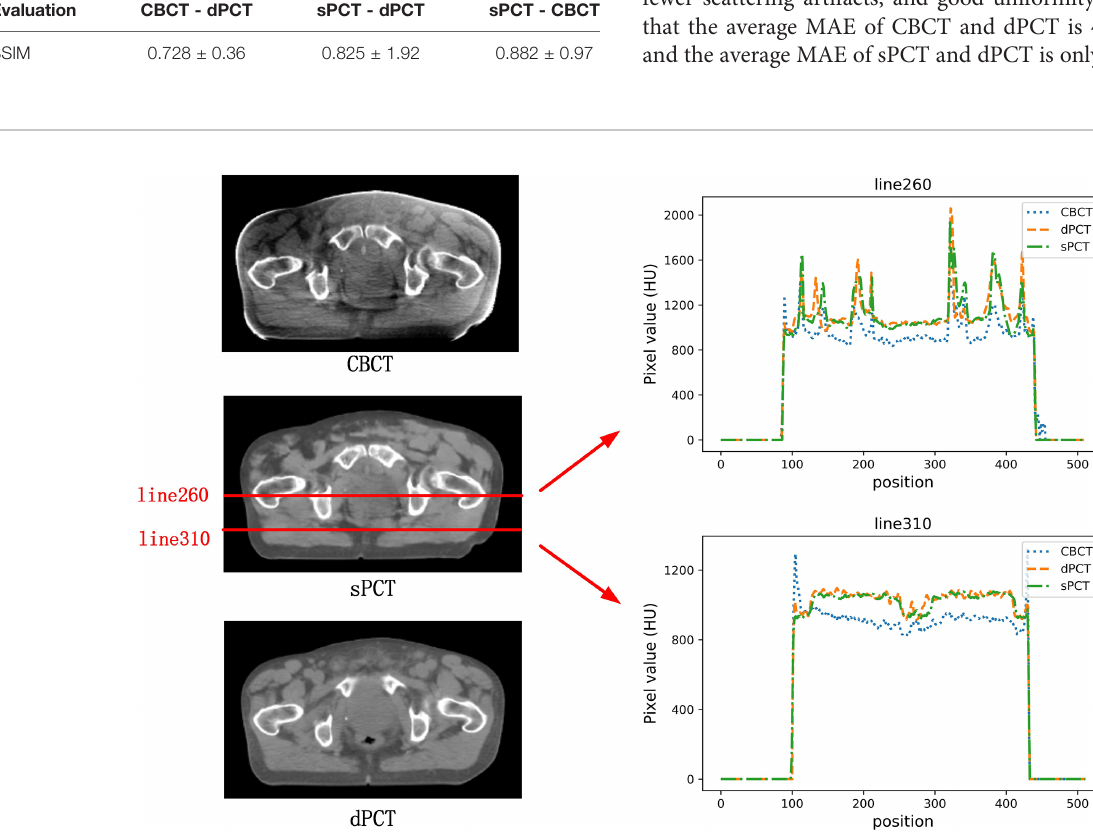
TABLE 2 | SSIM comparison of CBCT - dPCT, sPCT - dPCT, and sPCT - CBCT. Evaluation